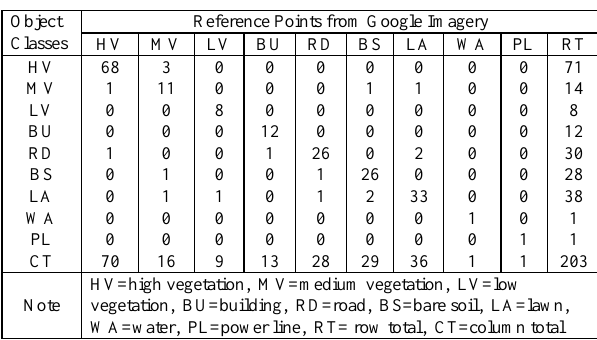
Table 2. The confusion matrix for nine classes